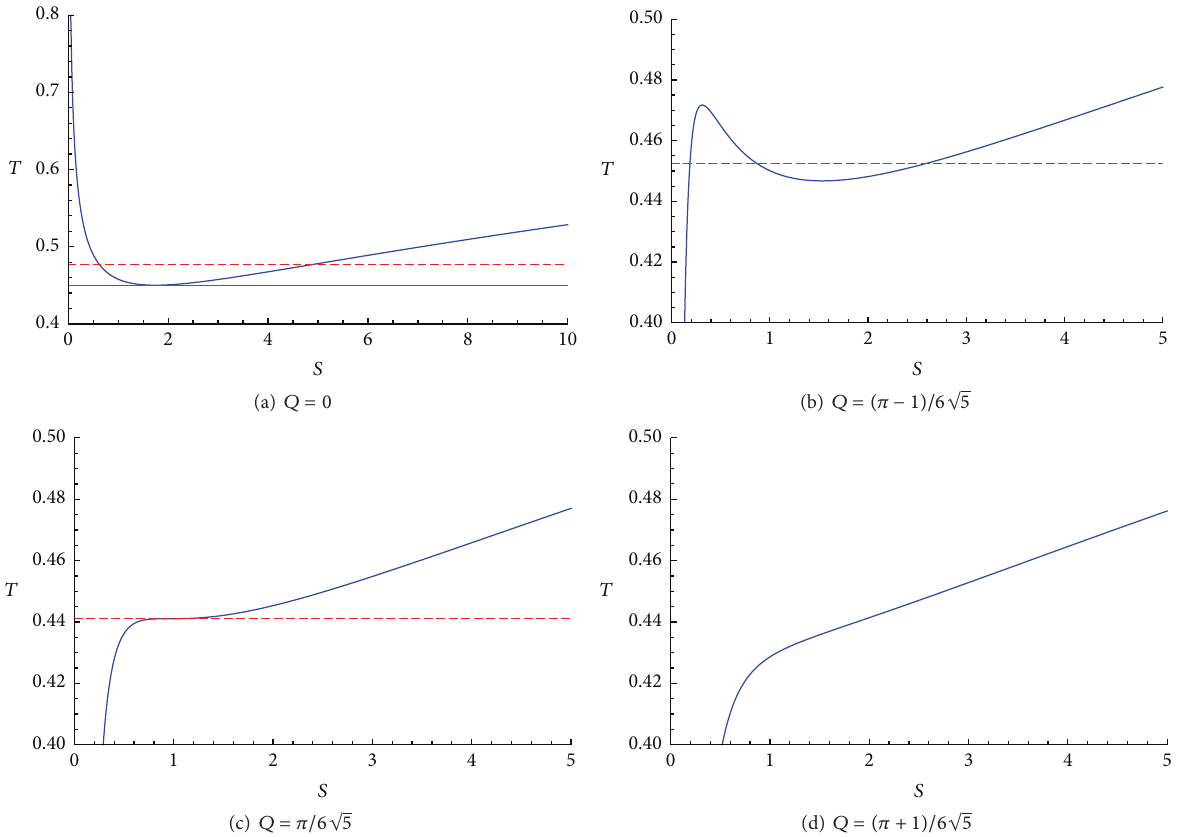
Figure 1: Relation between the entropy and temperature for different charges in the fixed charge ensemble. The red solid line corresponds to the minimum temperature of space time and the red dashed lines in (a), (b), and (c) correspond to the locations of Hawking-Page phase transition, first-order phase transition, and second-order phase transition